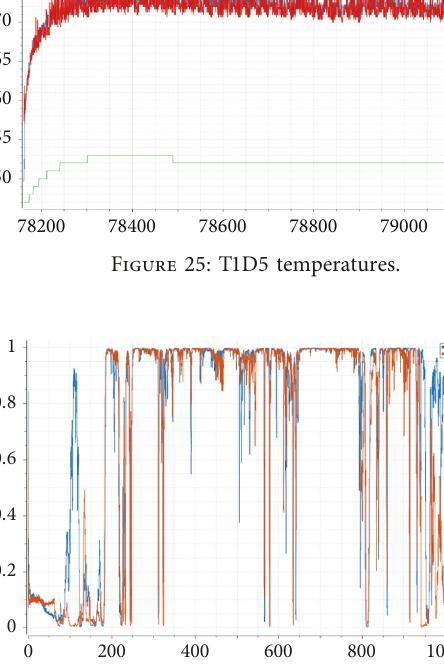
Figure 26: T1D6 left (1) and right (2) lane